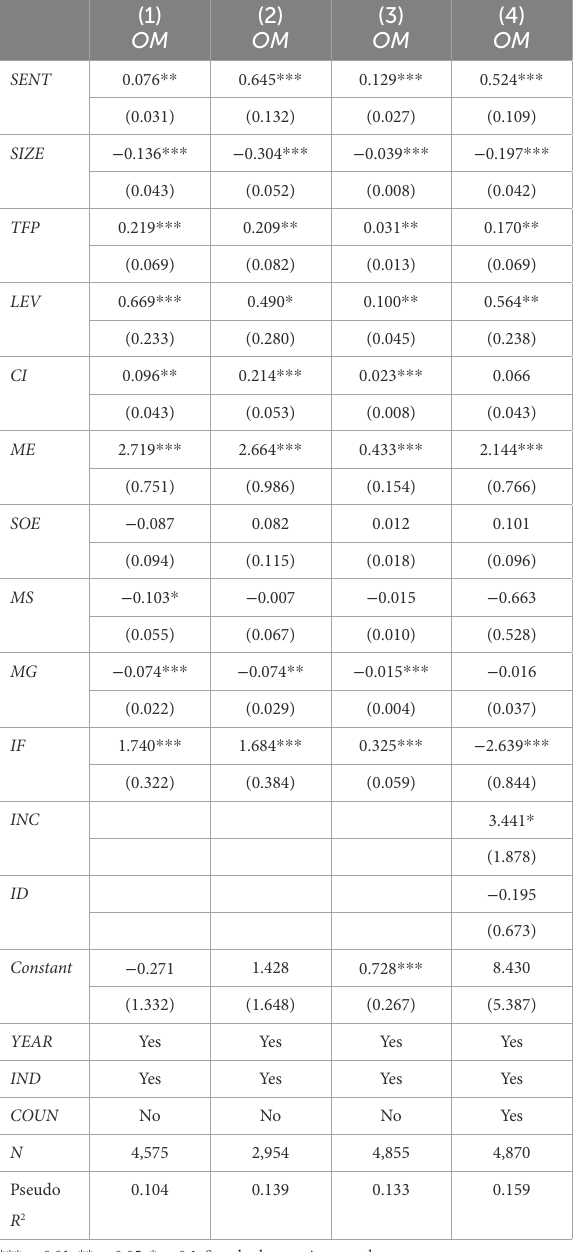
TABLE 7 Robustness